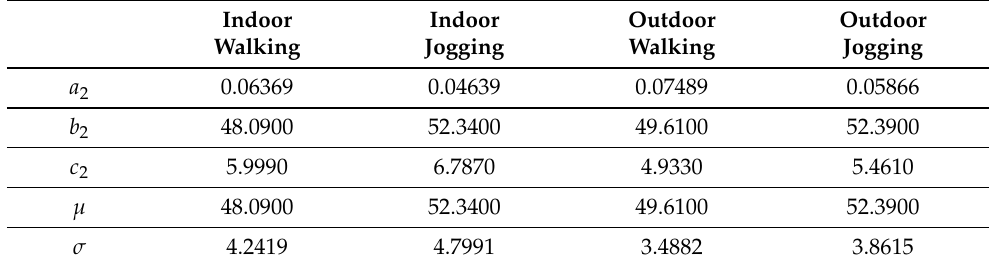
Figure 9. The probability histogram, the two-term Gaussian distribution, and the fitting curve of the second hump for the indoor and outdoor experiments. ( a ) Indoor walking; ( b ) indoor jogging; ( c ) outdoor walking; ( d ) outdoor jogging. Table 5. Coefficients for the second hump-fitting